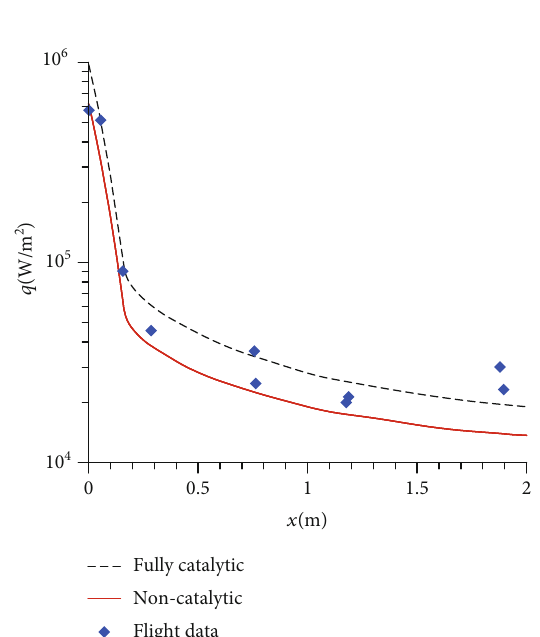
Figure 1: Flow fi eld parameters of ELECTRE.